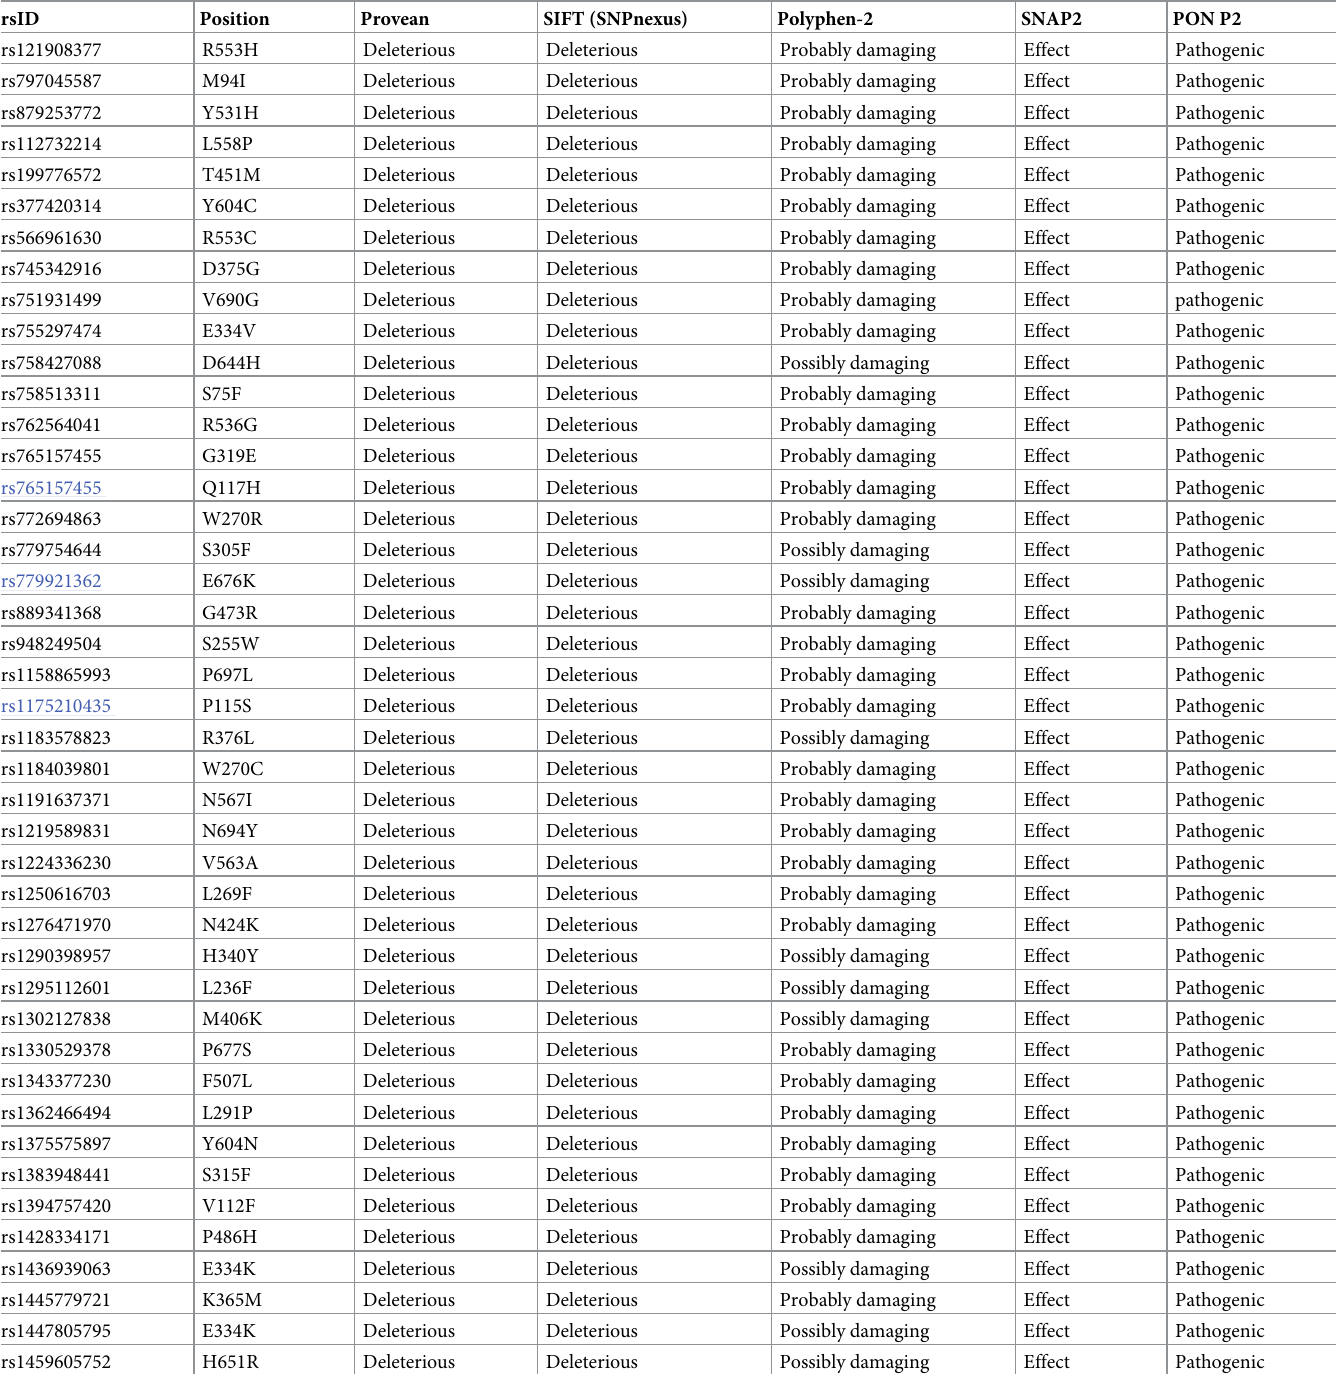
Table 1. High-risk non-synonymous SNPs predicted by five computational tools.